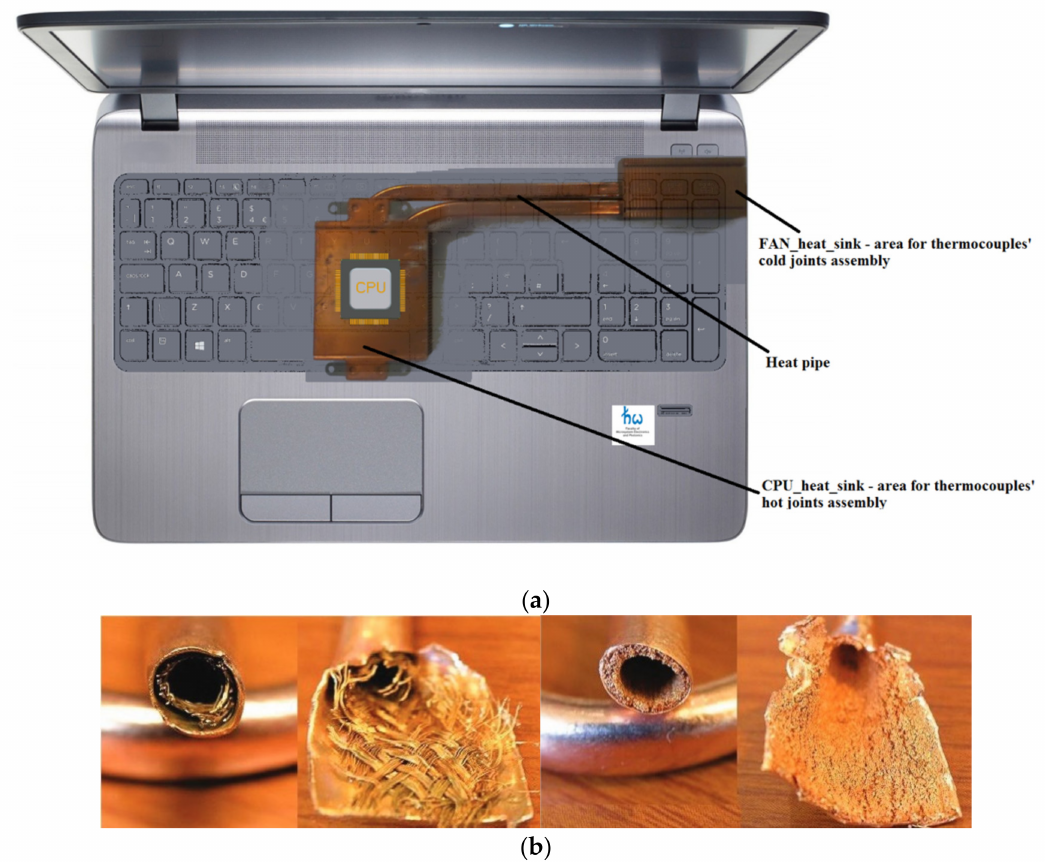
Figure 3. Active heat sink: ( a ) location in the laptop; ( b ) examples of cross-sections of different heat pipes [27].